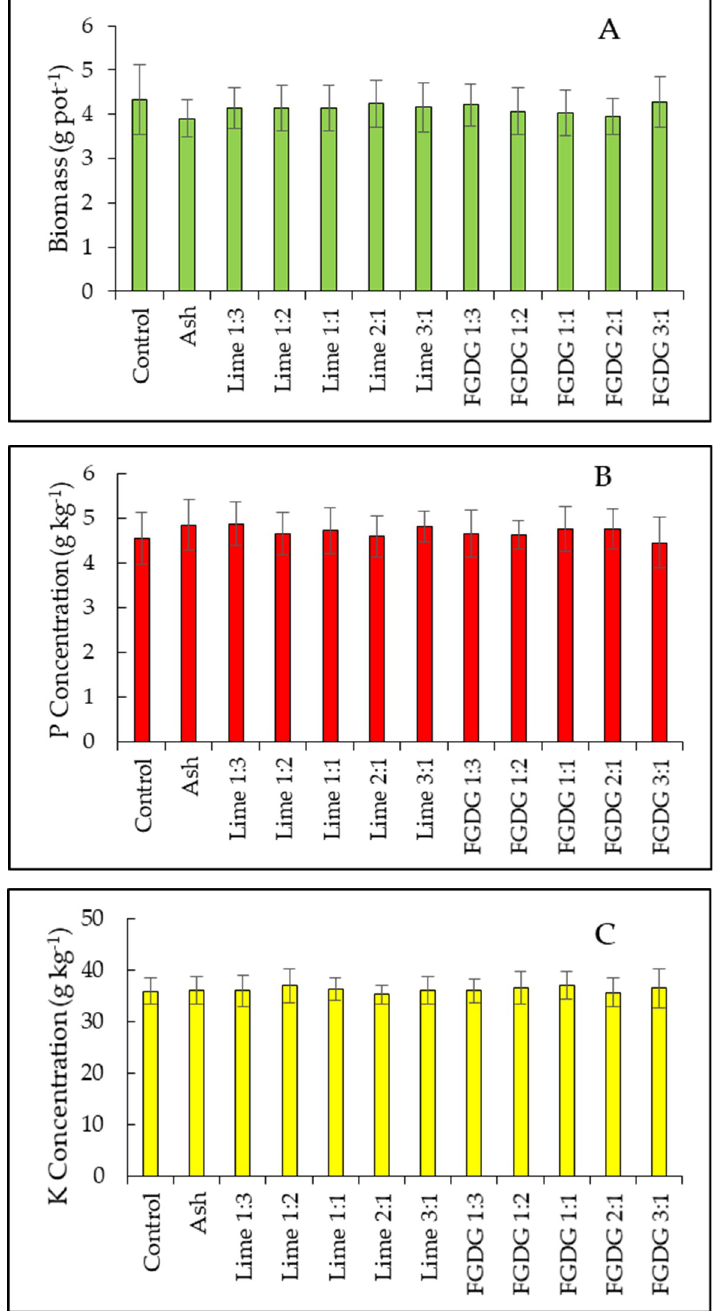
Figure 1. Effect of calcitic lime and flue gas desulfurization gypsum (FGDG) as fertilizer fillers for poultry litter ash on ryegrass biomass ( A ), P concentration in ryegrass ( B ), and K concentration in ryegrass ( C ). Error bars indicate ± one standard error of means.